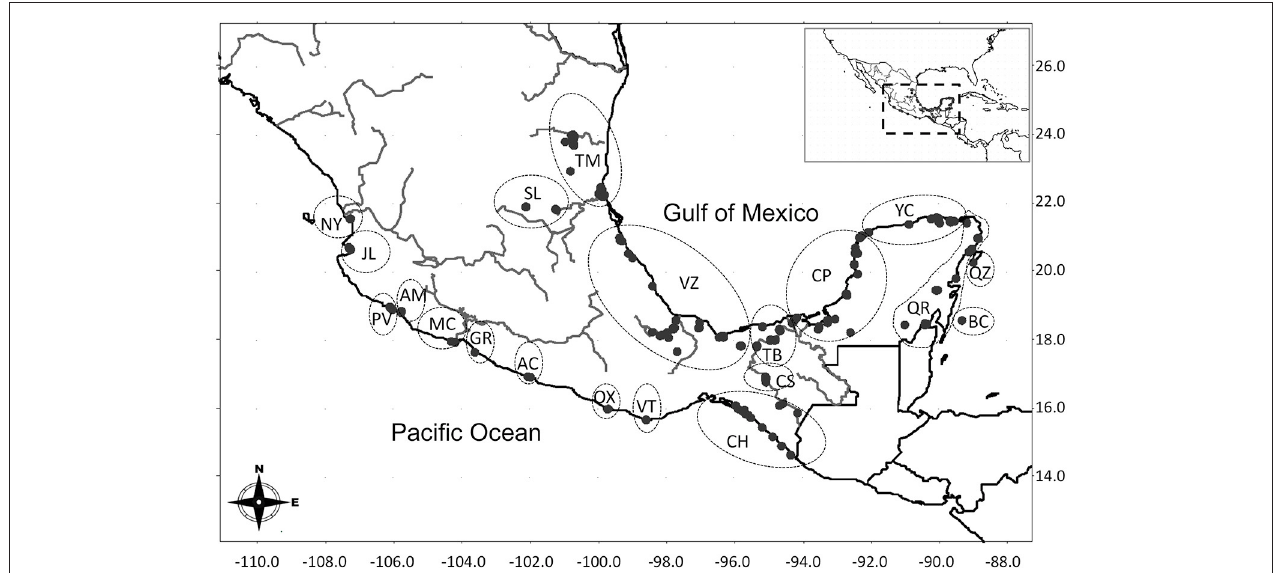
FIGURE 1 | Geographic distribution in Mexico of Crocodylus moreletii and C. acutus . Map of sampling localities for Crocodylus acutus and C. moreletii throughout Mexico. Every dot indicates individuals and sampling localities; the gray lines represent the river system. In order to place the sampling localities at the level of state in the map and in association with their description in Table S1 (Supporting Information), we grouped them (dotted circles) and codes refer to: TM, Tamaulipas; SL, San Luis Potosí; VZ, Veracruz; TB, Tabasco; CP, Campeche; YC, Yucatán; QR, Quintana Roo; QZ, Cozumel; BC, Banco Chinchorro; CS, Cañon del Sumidero; CH, Chiapas; VT, Ventanilla; OX, Chacahua; AC, Acapulco; GR, Guerrero; MC, Michoacan; AM, Amela; PV, Palo Verde; JL, Jalisco and NY,